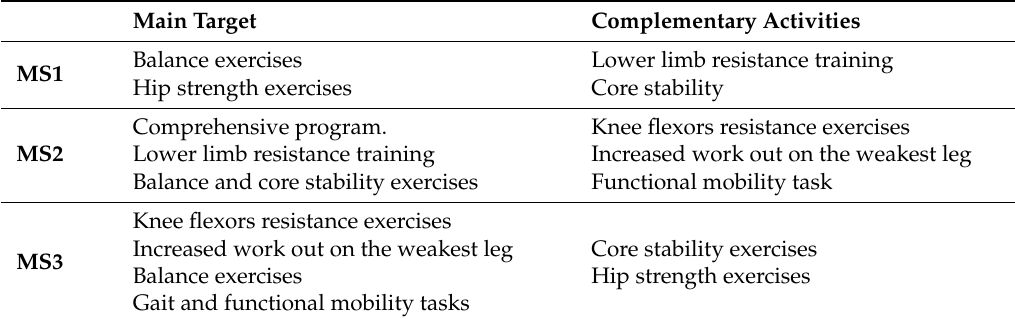
Table 4. Rehabilitation priorities for people with multiple sclerosis according to the EDSS